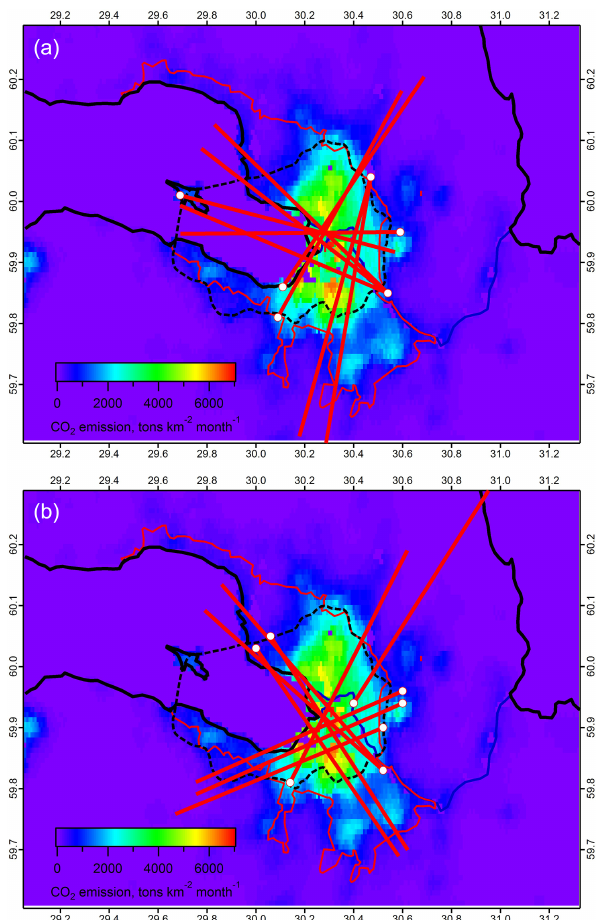
Figure 7. Map of air mass trajectories corresponding to field mea- surements of EMME experiments in March–April 2019 (a) and March–April 2020 (b) . For simplicity, the trajectories are desig- nated by straight lines, 50km long, ending at the locations of the downwind FTIR